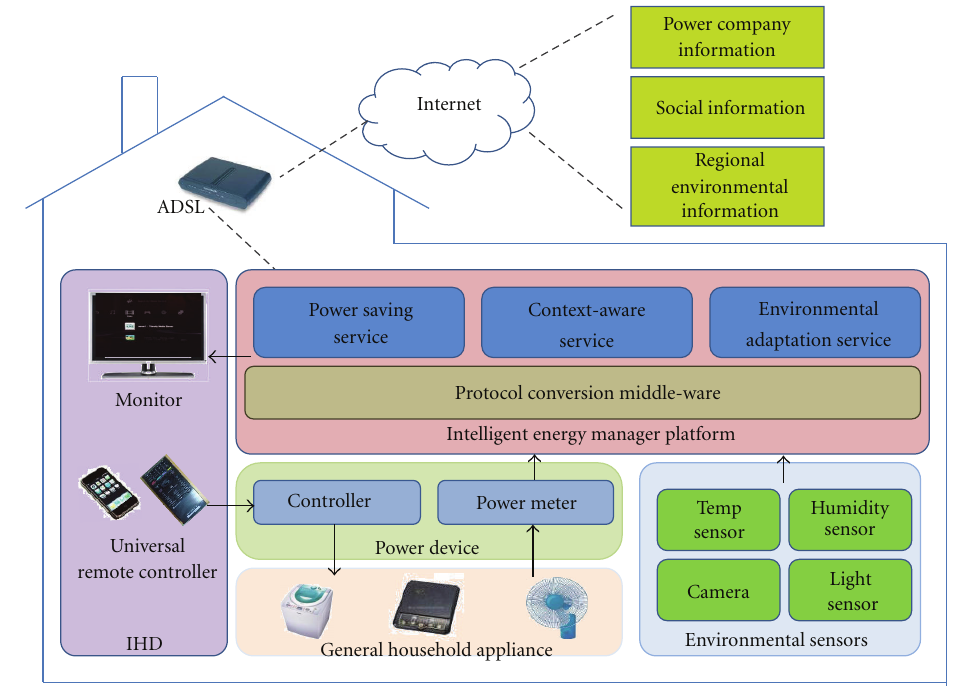
Figure 8: Future HEM system architecture.